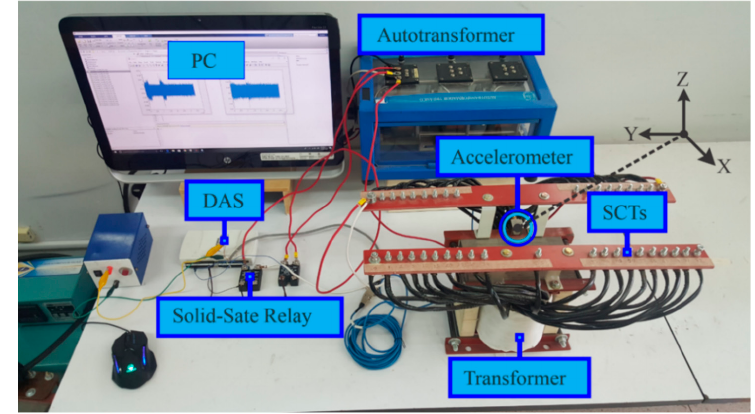
Figure 2. Experimental setup.